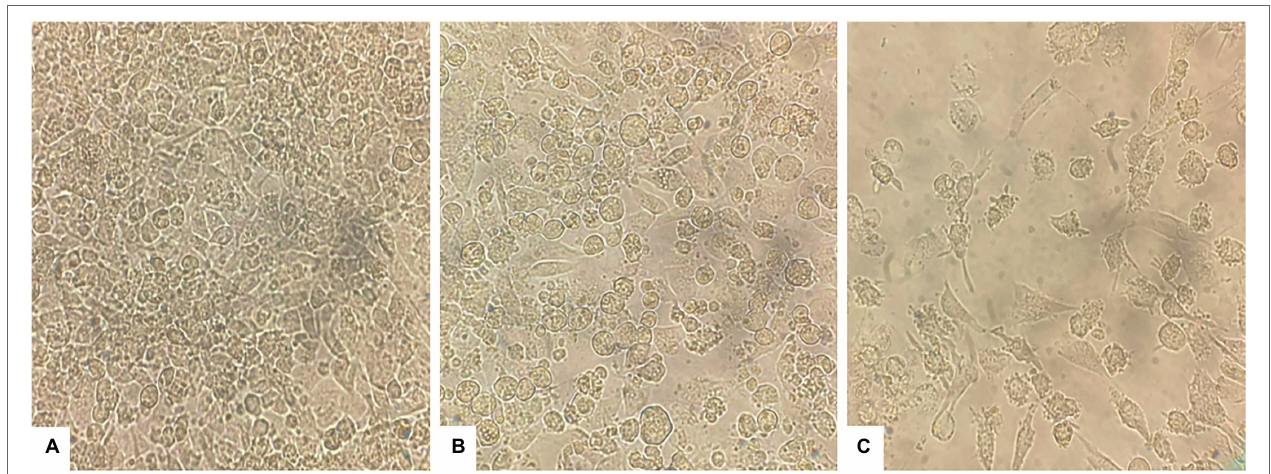
FIGURE 6 | PAAEs triggered morphological and apoptotic changes in HepG2 cells. These cell morphological changes were observed using an inverted microscope (original magnification, x400). (A) Control (untreated cells), (B) cells treated with 0.5% (v/v) dimethyl sulfoxide (DMSO) as comparative group, and